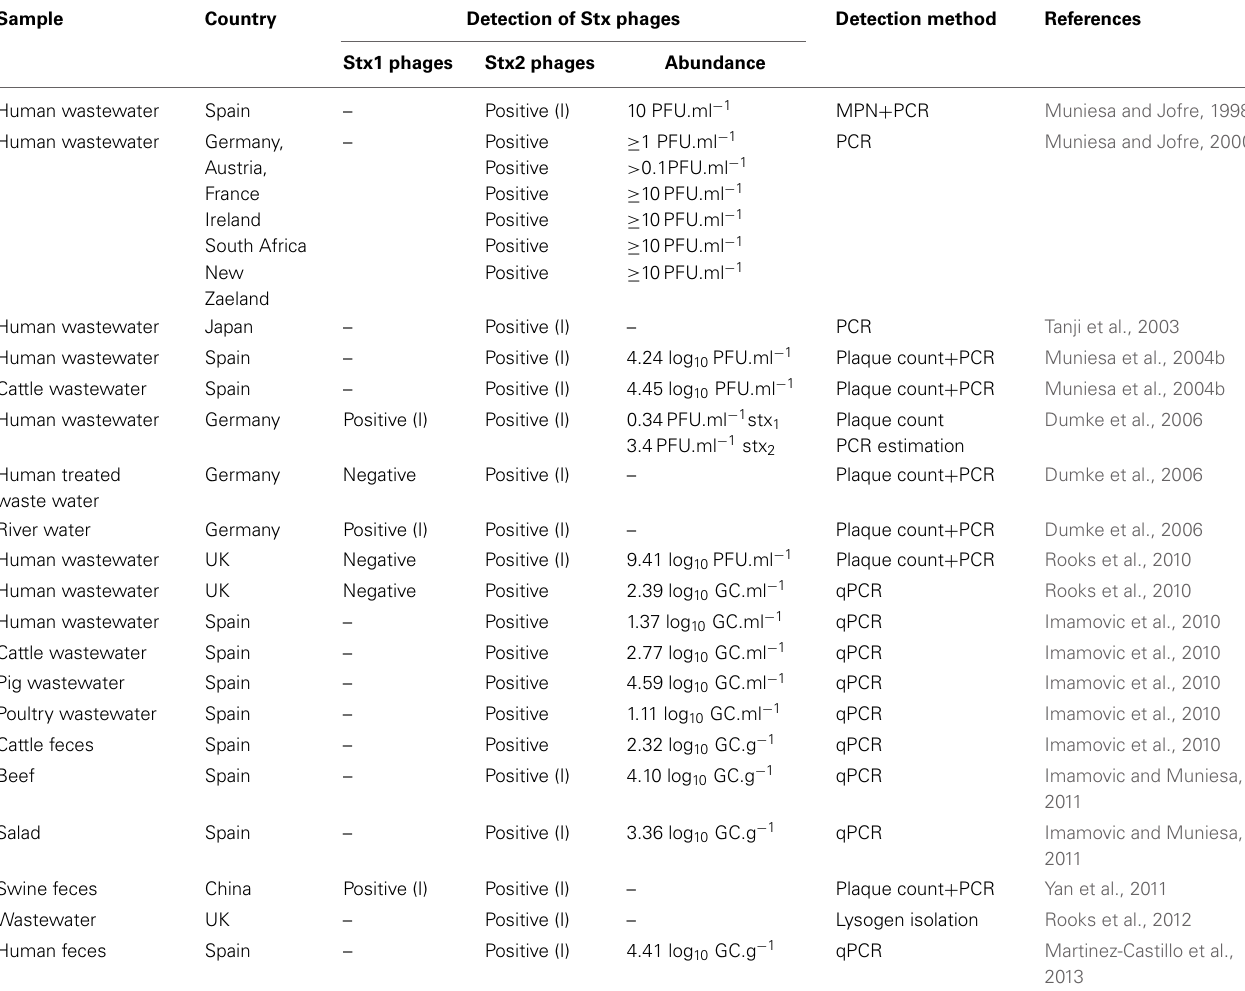
Table 1 | Occurrence and abundance of free Stx bacteriophages in diverse